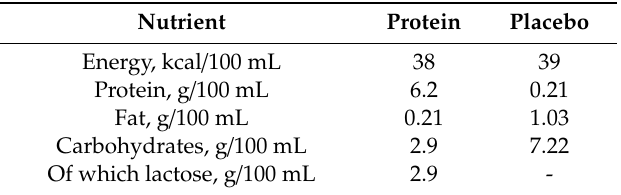
Table 1. Nutritional composition of protein and placebo supplements. Nutrient